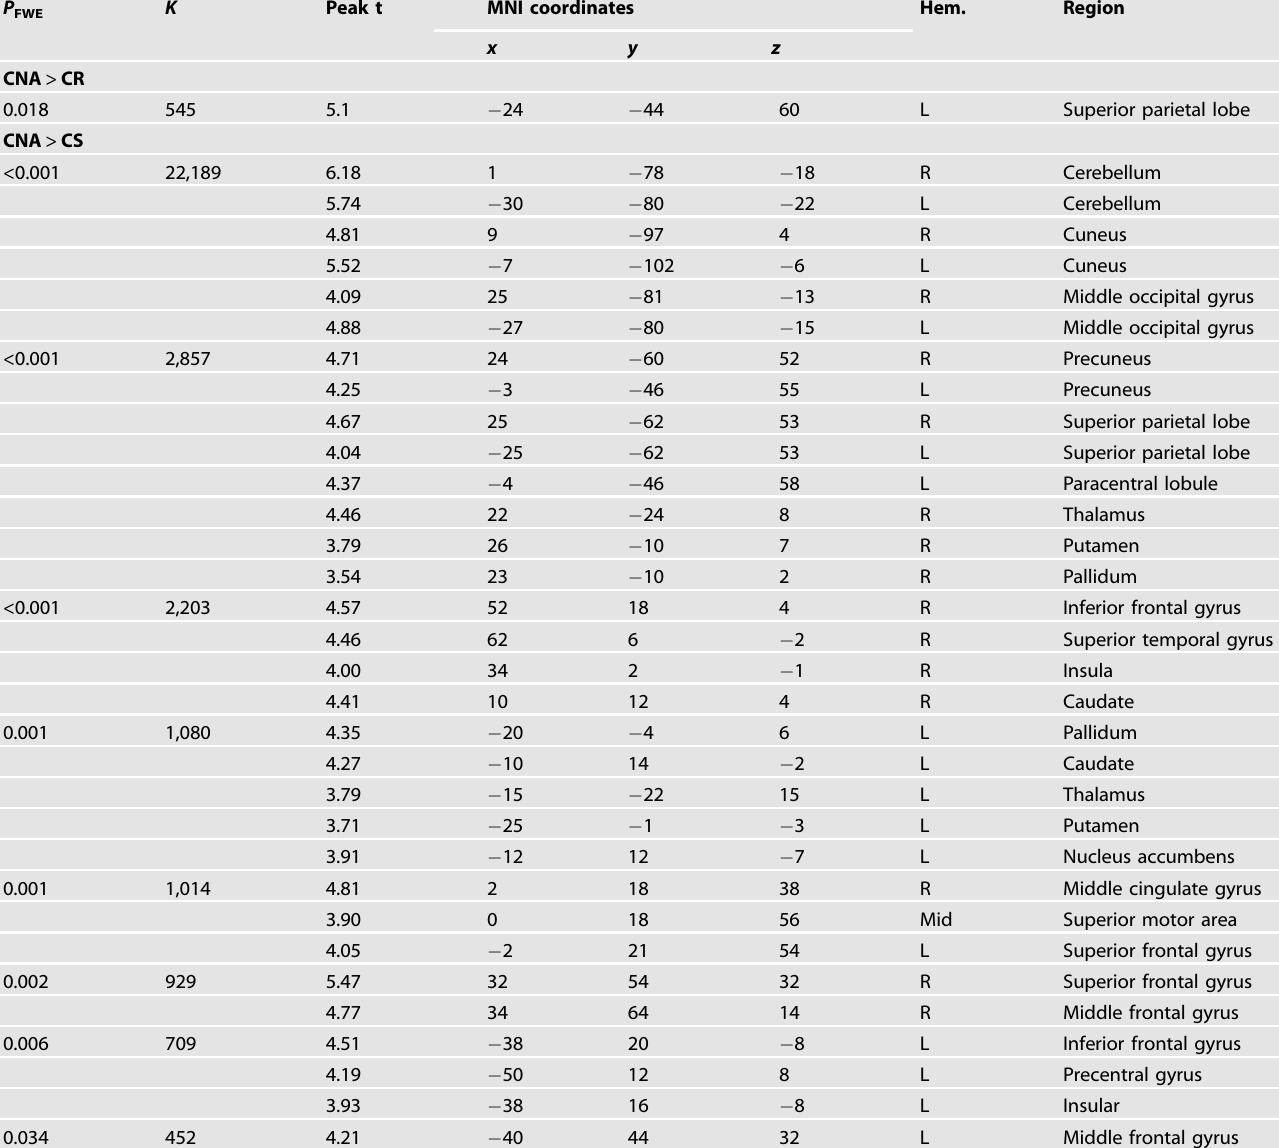
Table 2. Brain regions exhibiting a signi fi cant difference between subtypes in the resting-state functional connectivity of the bilateral amygdala ( p < 0.001).